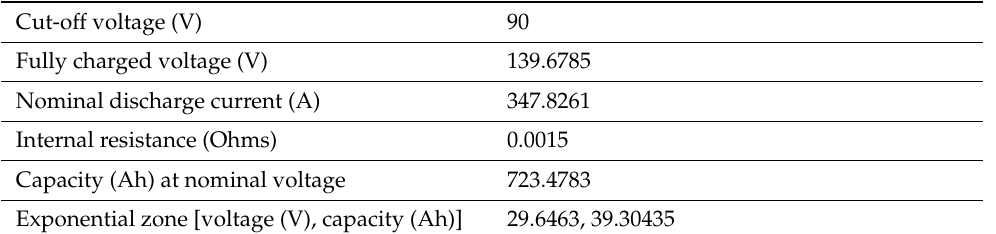
Table 1. Main parameters of Lithium-ion battery.